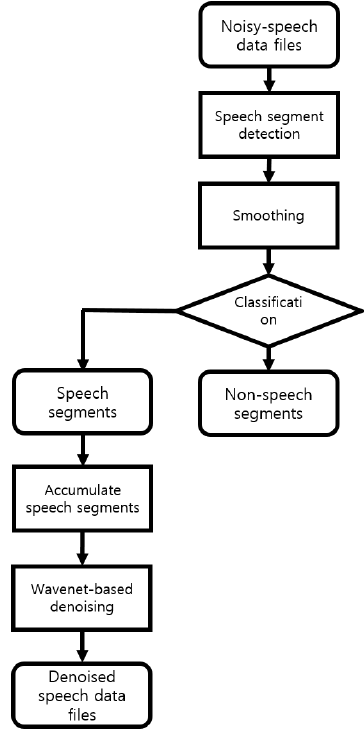
Figure 5. The overall denoising process based on the speech segment